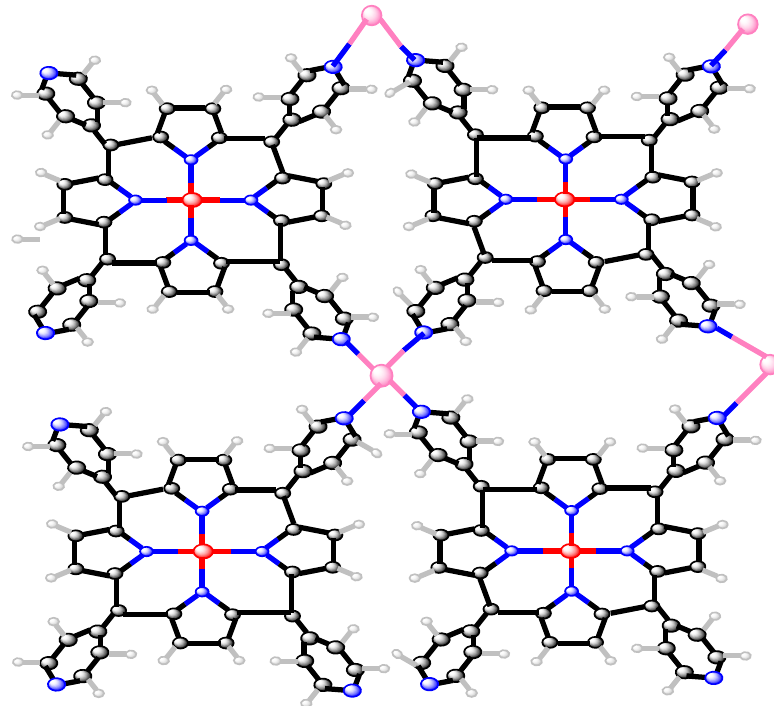
Figure 3. Two-dimensional MOF_(2,2) structure.